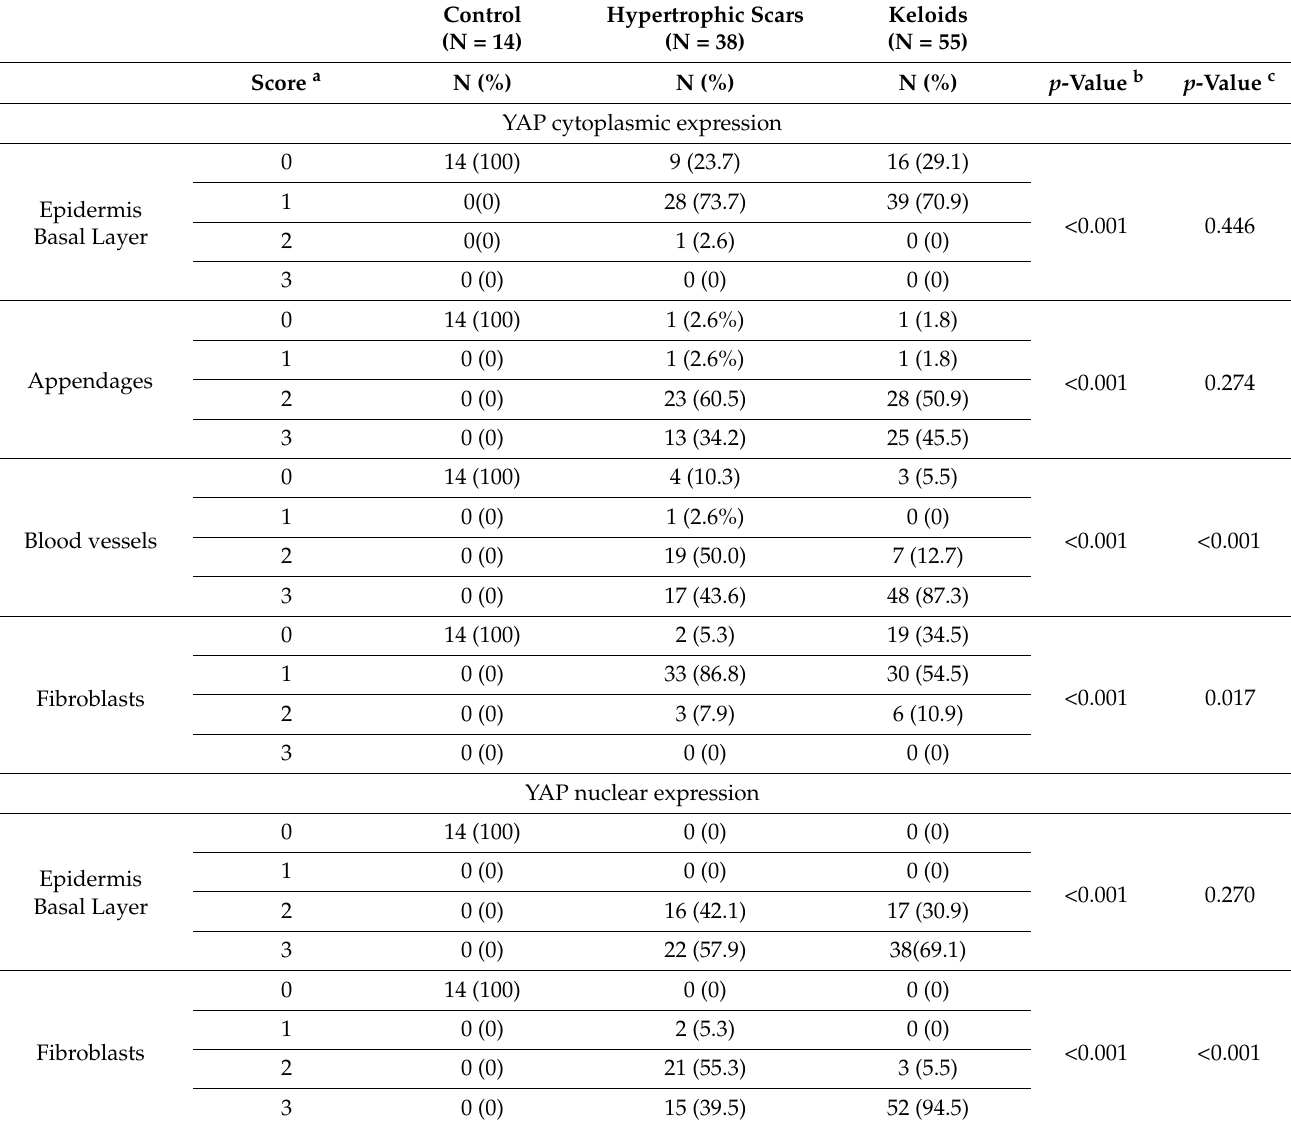
Table 2. Immunohistochemical analysis of YAP expression in control skin, hypertrophic scars and keloids.